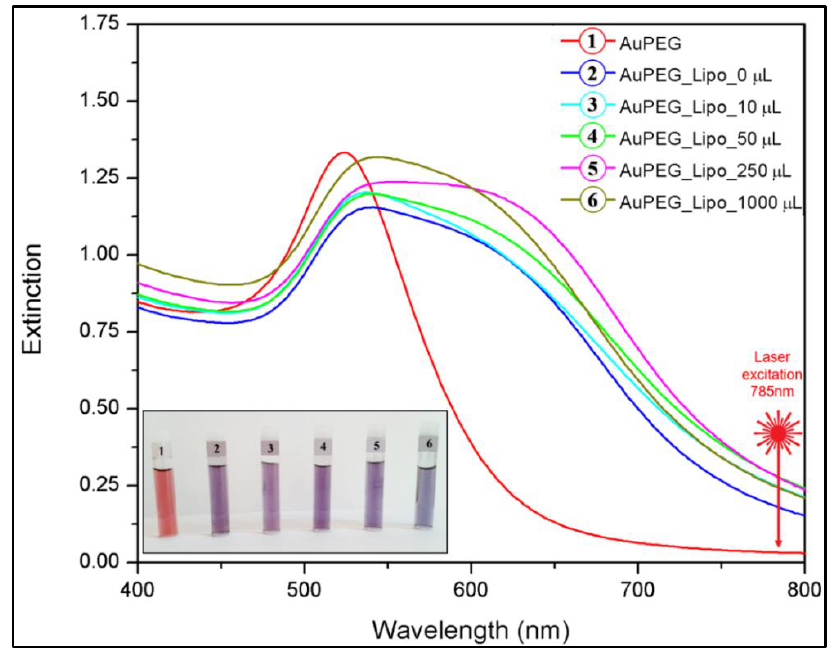
Figure 7. VIS absorption spectra of the PEGylated gold colloids (1), and of the complexes they formed with pure liposomes (2) and MLPs containing different amounts of MNPs in their bilayers (3–6). The inset shows the optical images of the gold colloids and their liposomal complexes with their respective liposomal batch number: 1–0 μL, 2–10 μL, 3–50 μL, 4–250 μL, 5–1000 μL. The samples were diluted four times before image recording. Nanomaterials 2019 , 9 , x FOR PEER REVIEW